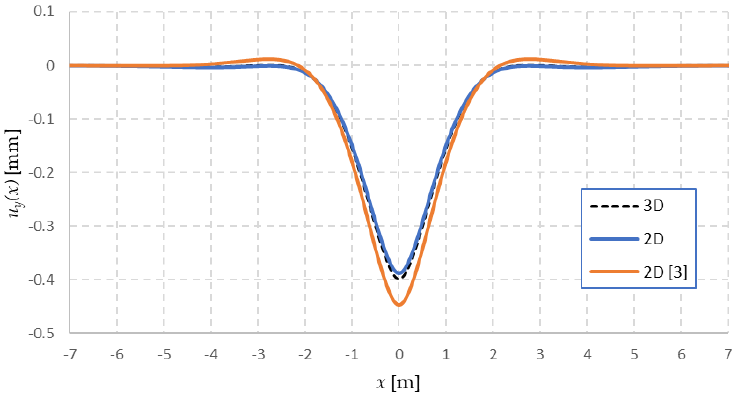
Figure 16. Static vertical displacement of the rail. Comparison of the model proposed in this paper, the model from [3] and the 3D FE model